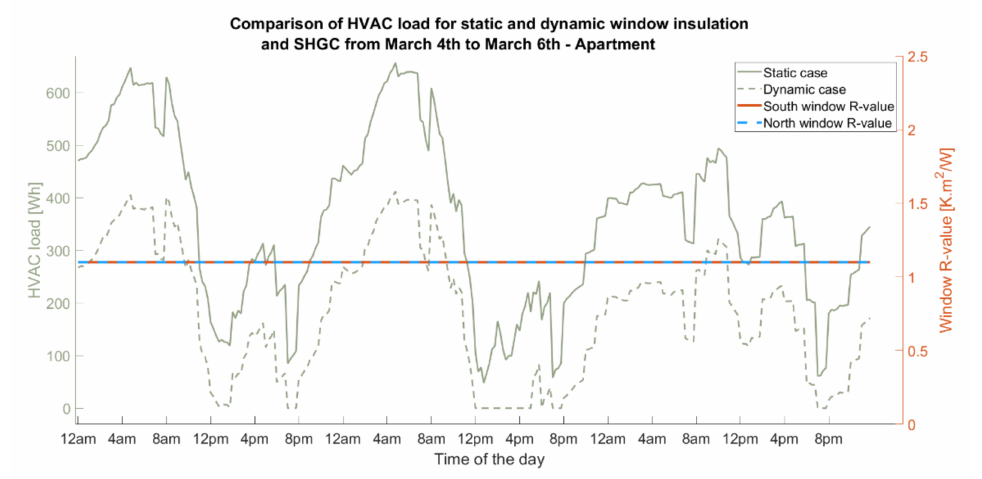
Figure 7. Comparison of HVAC loads for static and dynamic windows from 4 March to 6 March for the prototypical apartment unit. For dynamic windows, high R-value = 1.1 m 2 · K/W; low R-value = 0.45 m 2 · K/W; high SHGC = 0.4; low SHGC = 0.1. For static windows, R-value = 0.45 m 2 · K/W; SHGC = 0.4.